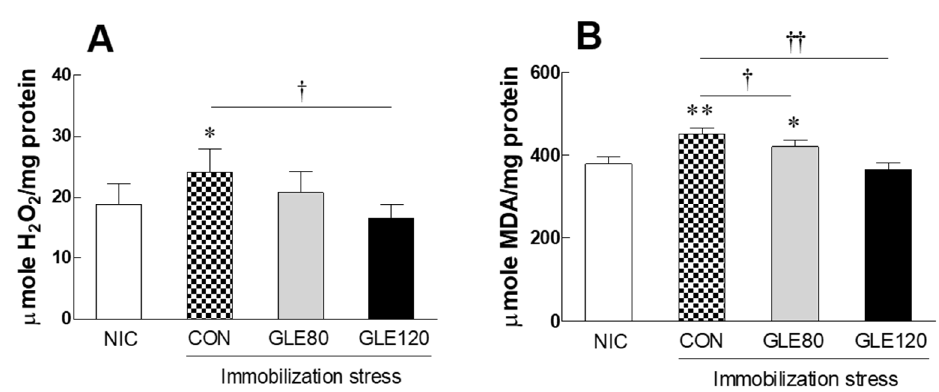
Figure 4. Effects of GLE (green lettuce leaf extract) on ( A ) hydrogen peroxide and ( B ) malondialdehyde by immobilization stress in rats. Experimental groups include the no-immobilization-stress control group (NIC), control group (CON, stress-induced immobilization), and GLE (green lettuce leaf extract)-treated groups with stress (80 and 120 mg/kg). Values are presented as the mean ± standard error of the mean (SEM) for each group, n = 8. * p < 0.05 and ** p < 0.01 when compared with the NIC group. † p < 0.05 and †† p < 0.01 when compared with the CON group (ANOVA followed by post-hoc Tukey’s test).